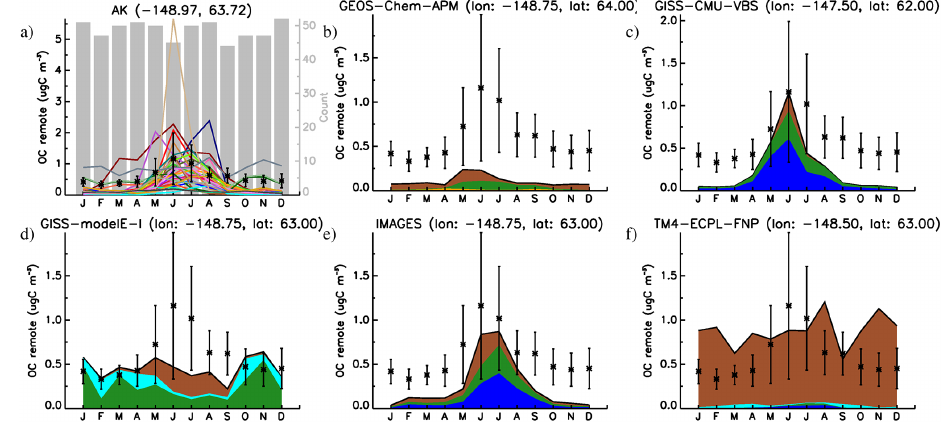
Figure 21. Same as in Fig. 18, for Alaska, USA (remote, years 2002–2006). For the chemical composition in (b–f) , brown is tPOC, green is trSOC, cyan is mPOC, blue is ntrSOC, and orange is MSA.